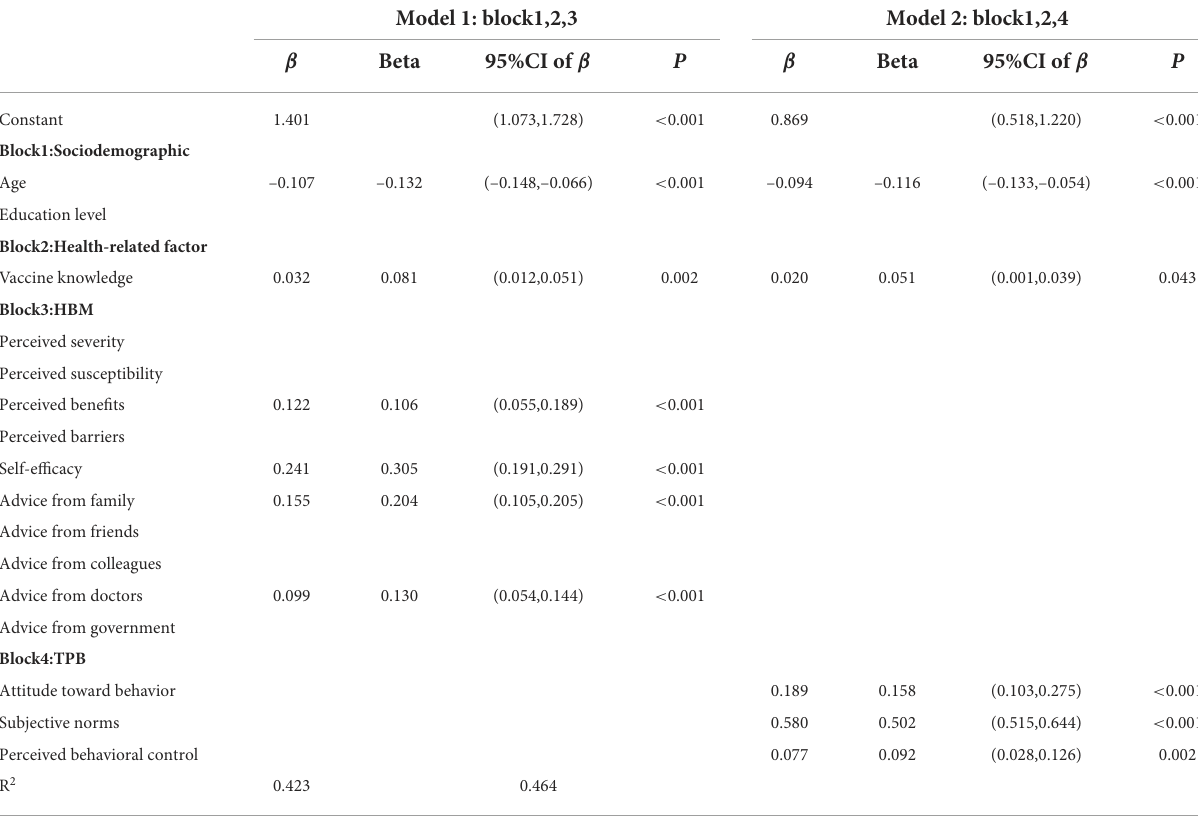
TABLE 3 Multiple linear regression analysis - predictors of intention to get future vaccinated against COVID-19 (the vaccine-hesitant